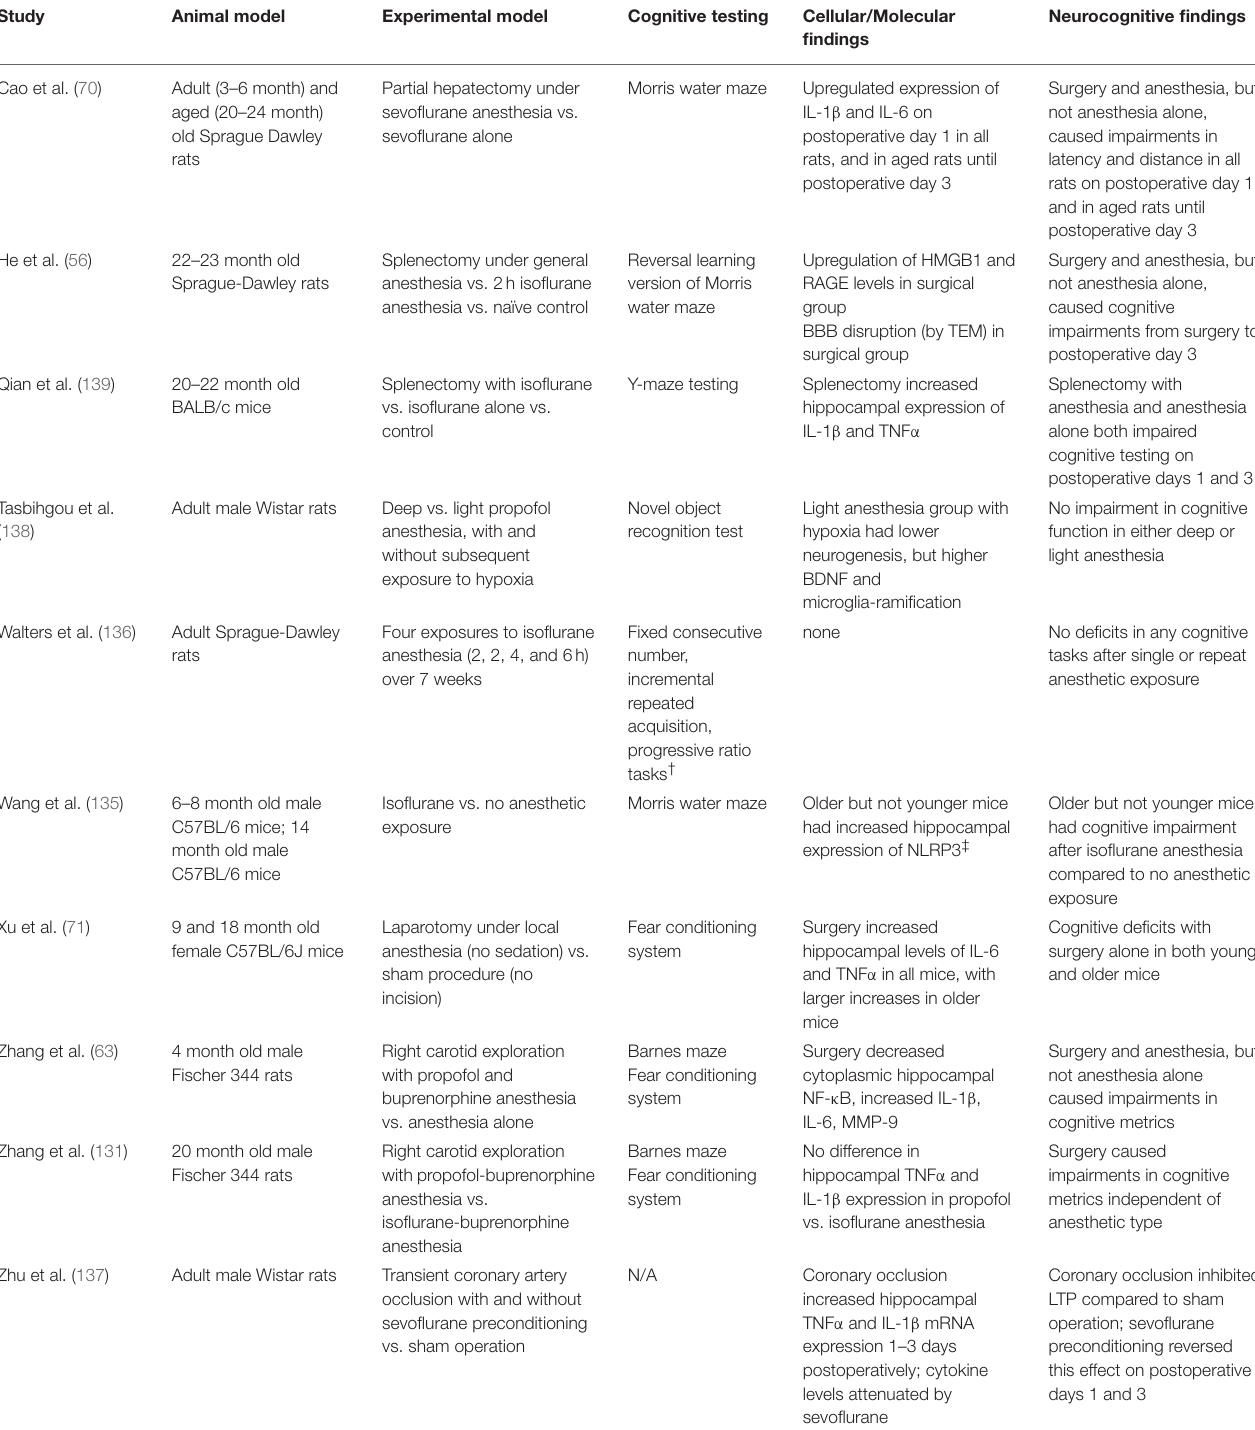
TABLE 1 | Selected relevant pre-clinical studies on etiology of POCD.